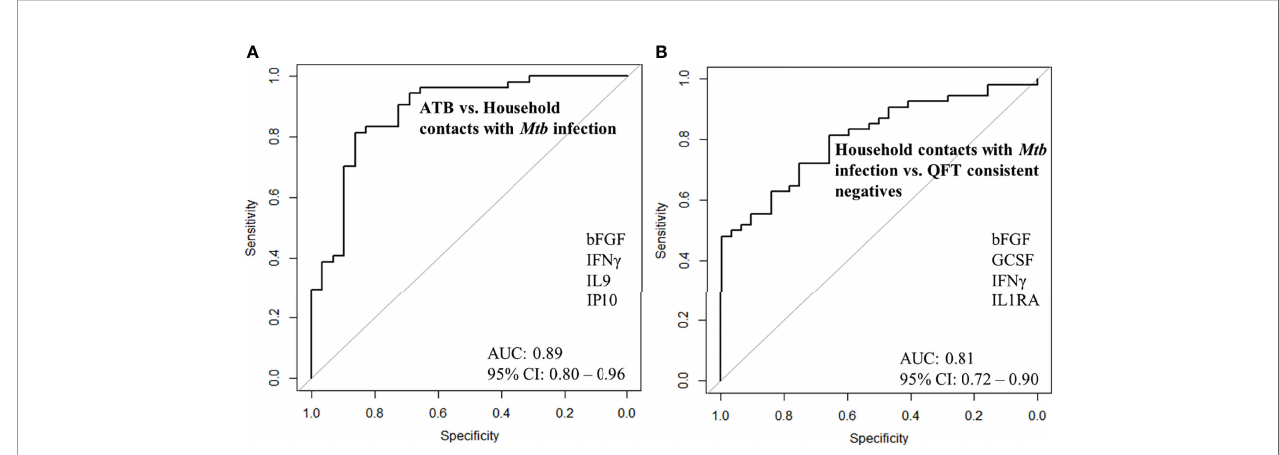
FIGURE 5 | ROC curves for signature that distinguishes (A) Active TB (n = 29) from Household contacts with Mtb infection (n = 30), (B) Household contacts with Mtb infection (n = 30) from QFT consistent negatives (n = 32).